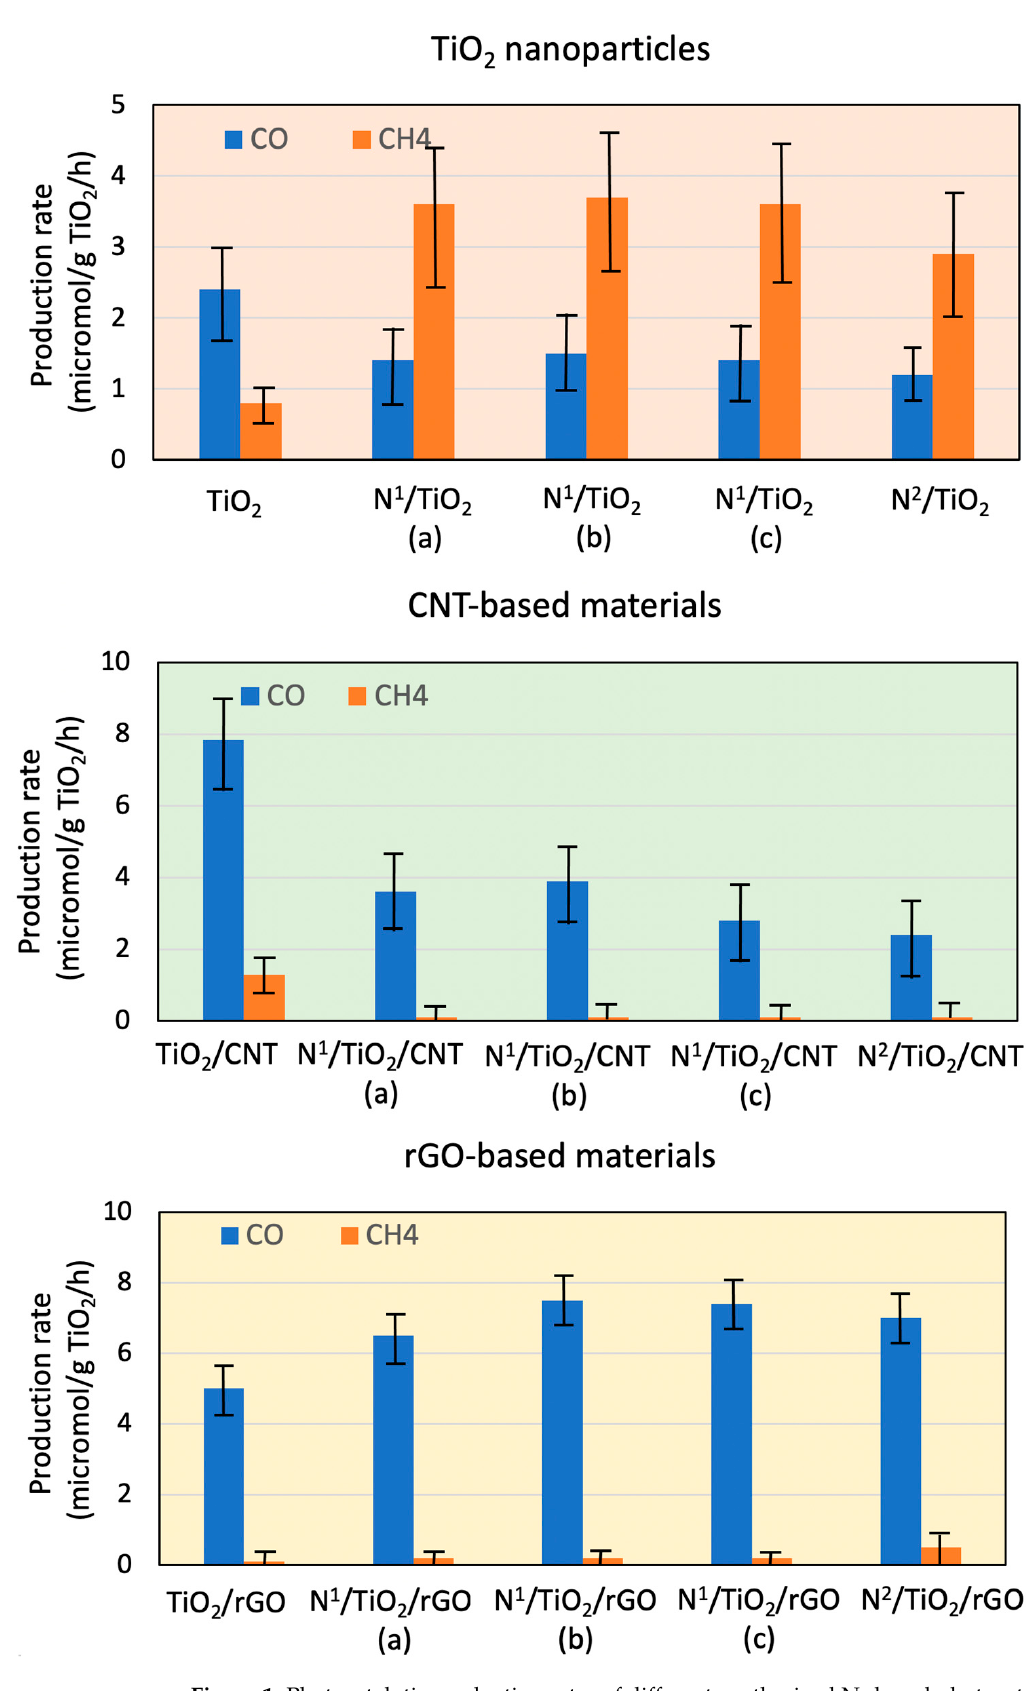
Figure 1. Photocatalytic production rates of different synthesized N-doped photocatalysts.